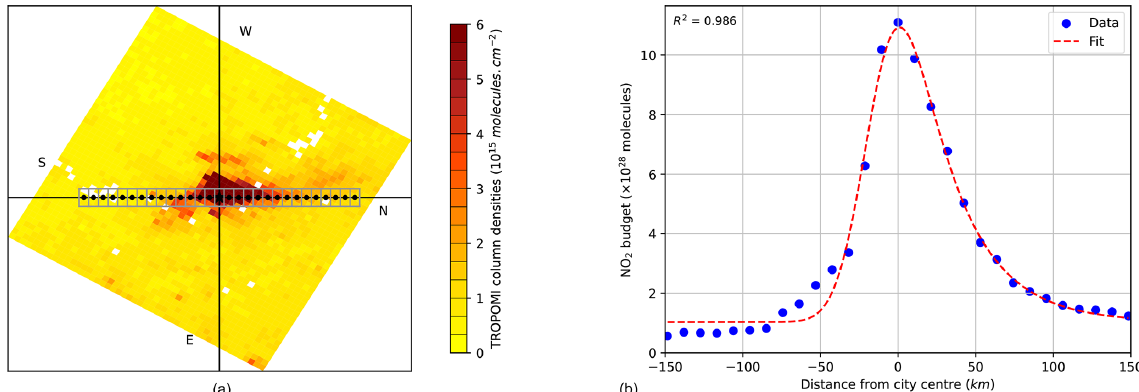
Figure 3. Estimation of the NO 2 lifetime from a pattern above Riyadh on 11 March 2020: (a) NO 2 plume rotated with its wind direction around the source (star) to an upwind–downwind pattern. Grey boxes centred around black points indicate the extent of the spatial integration of NO 2 columns to obtain the NO 2 line density. Values of cardinal points are noted in black. (b) Corresponding line densities (points) representing the downwind evolution of NO 2 as a function of the distance to Riyadh’s city centre and the corresponding fit according to the exponentially modified Gaussian function (dashed line).